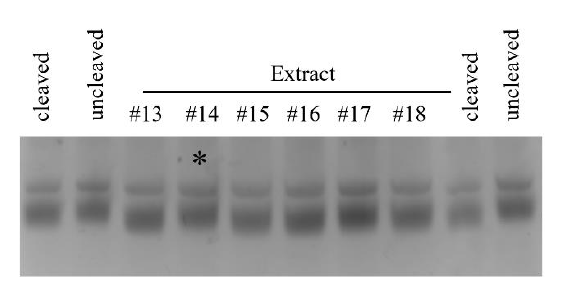
Figure 5. Natural Product Inhibition of B. cereus Pth1. Shown is an example of typical inhibition data, cleaved represents the positive control containing fully active Pth1 with no inhibitor. Uncleaved is the negative control, substrate peptidyl-tRNA with no Pth1. The * indicates inhibition by the natural product extract. The lower band is the substrate peptidyl-tRNA that exhibit migration differences based on cleavage state. The top band is 5S rRNA, an artifact of purification, that serves as an internal standard.